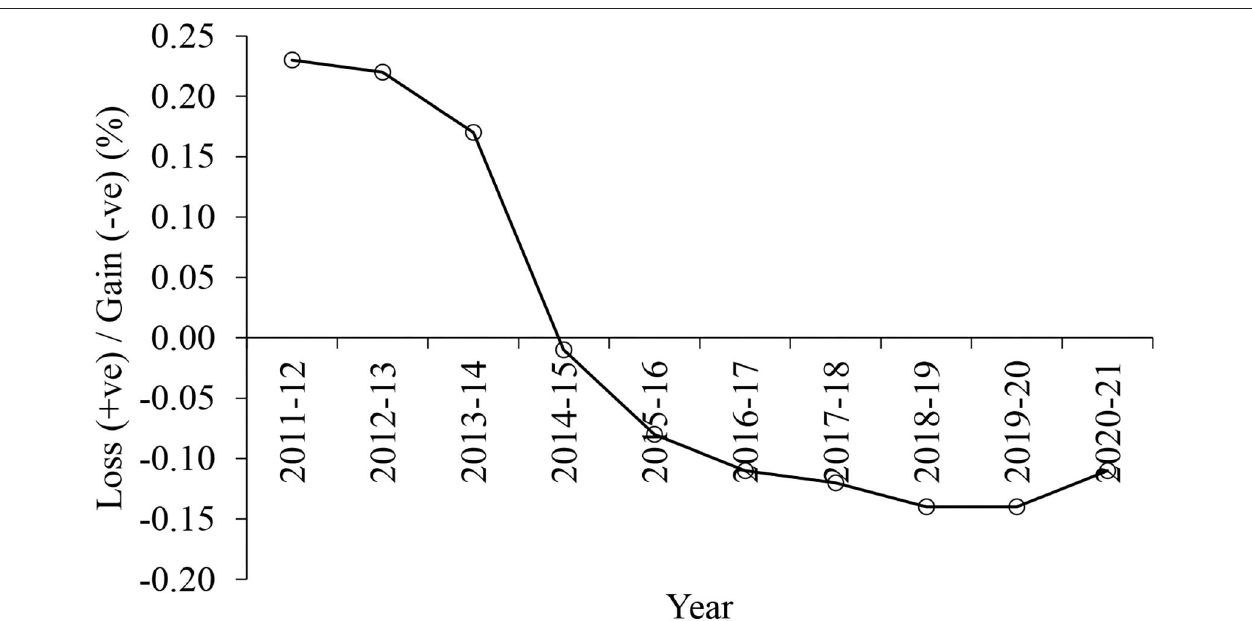
FIGURE 6 | Storage losses of wheat observed by FCI in